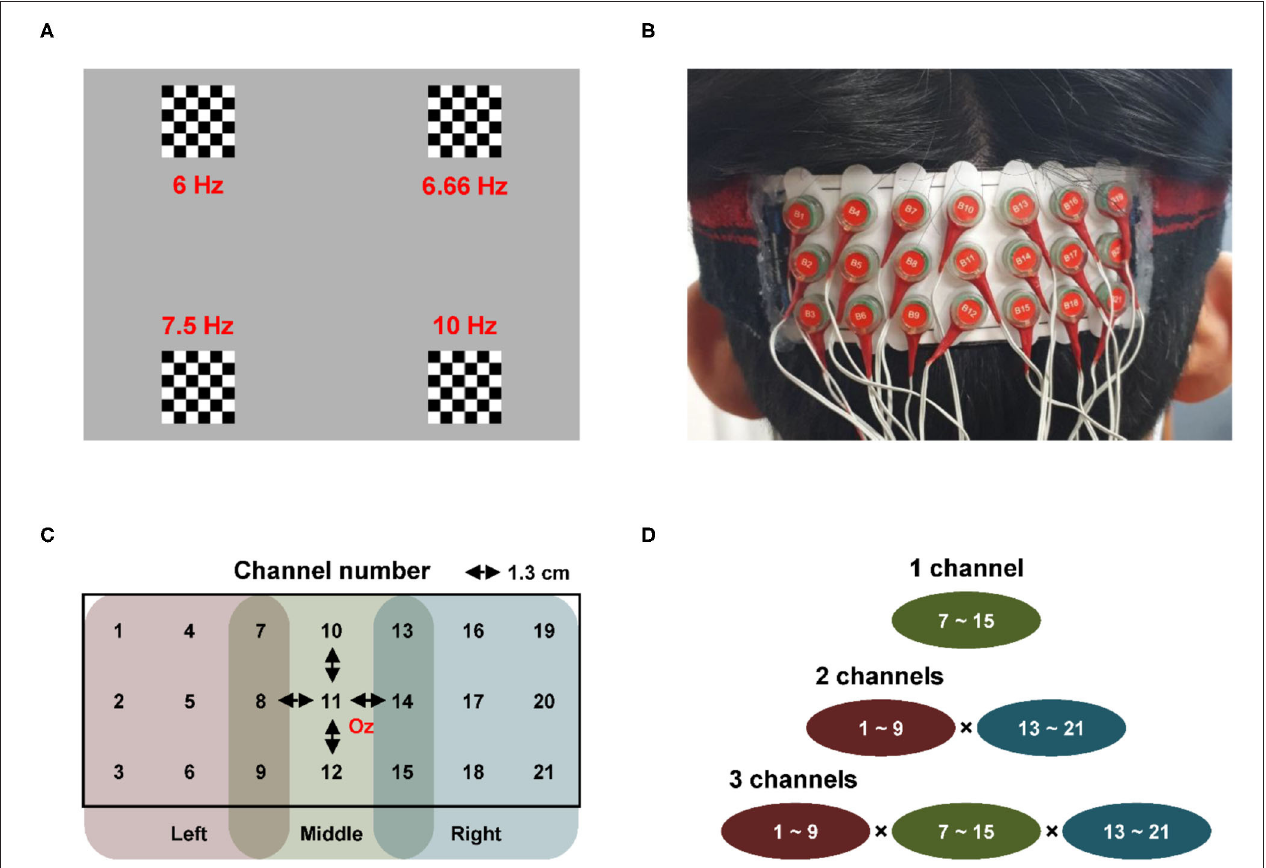
FIGURE 1 | Experiment setup and channel combination (A) four 6 × 6 pattern-reversal checkerboard stimuli [frequencies of the four stimuli were set to 6Hz (top left), 6.66Hz (top right), 7.5Hz (bottom left), and 10Hz (bottom right)] (B) fabricated electrode array pad with dense electrode configuration (C) array pad [distance between the two neighboring electrodes was set to 1.3cm,; center of the array pad was placed at Oz and according to the extended international 10–20 system; 21 channels were categorized into three categories depending on the location of the channel: left (channel 1–9), middle (channel 7–15), and right (channel 13–21)] (D) possible channel combinations with respect to the number of channels used for classification [for example, when two EEG signals recorded at two channels were used to classify the frequency of SSVEP, the classification accuracy was calculated in a total 81 channel combinations by combining the left 9 channels (channel 1–9) and right 9 channels (channel